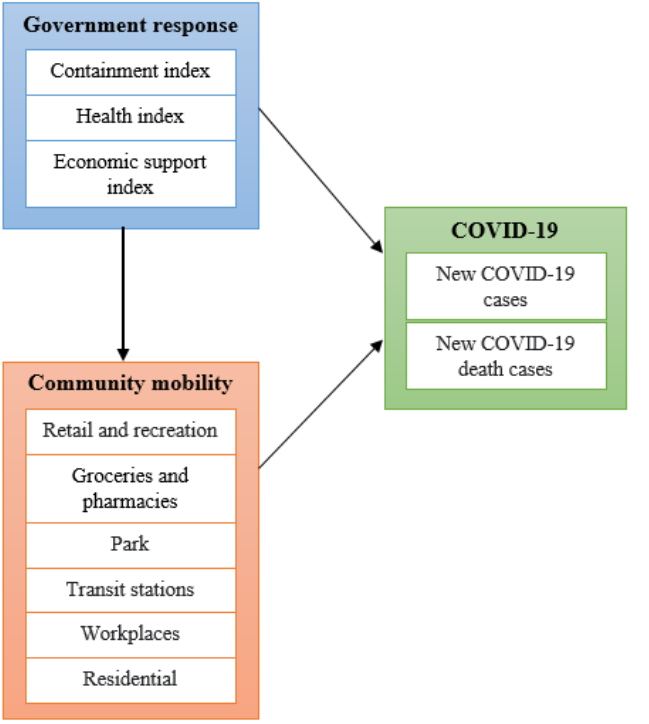
Figure 1. Conceptual model of the studied variables.